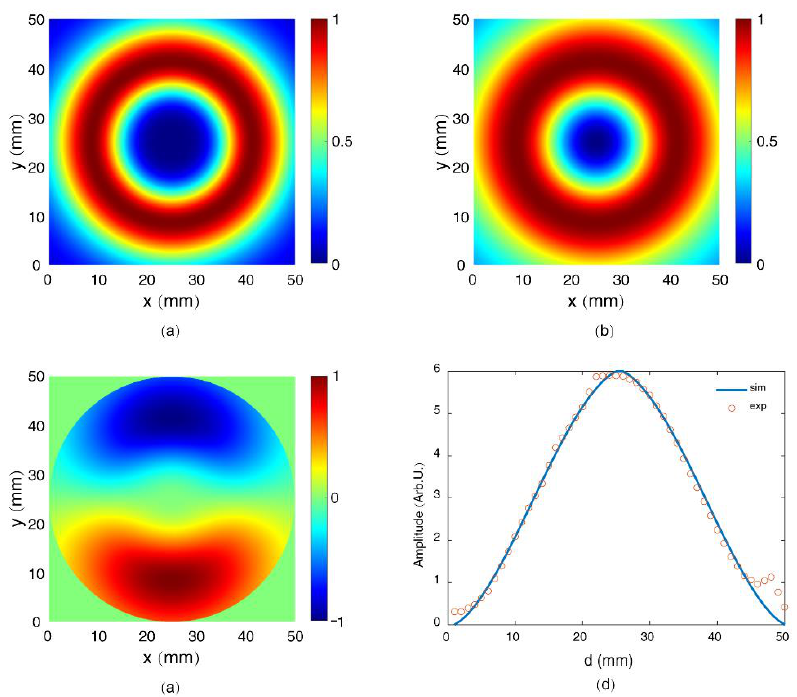
Figure 7. Spatial distribution of ( a ) the energy density, ( b ) the field amplitude, and ( c ) the vertical components of the THz radiation from a longitudinally dc-biased filament. ( d ) Simulation and experimental results for THz amplitude as a function of d .